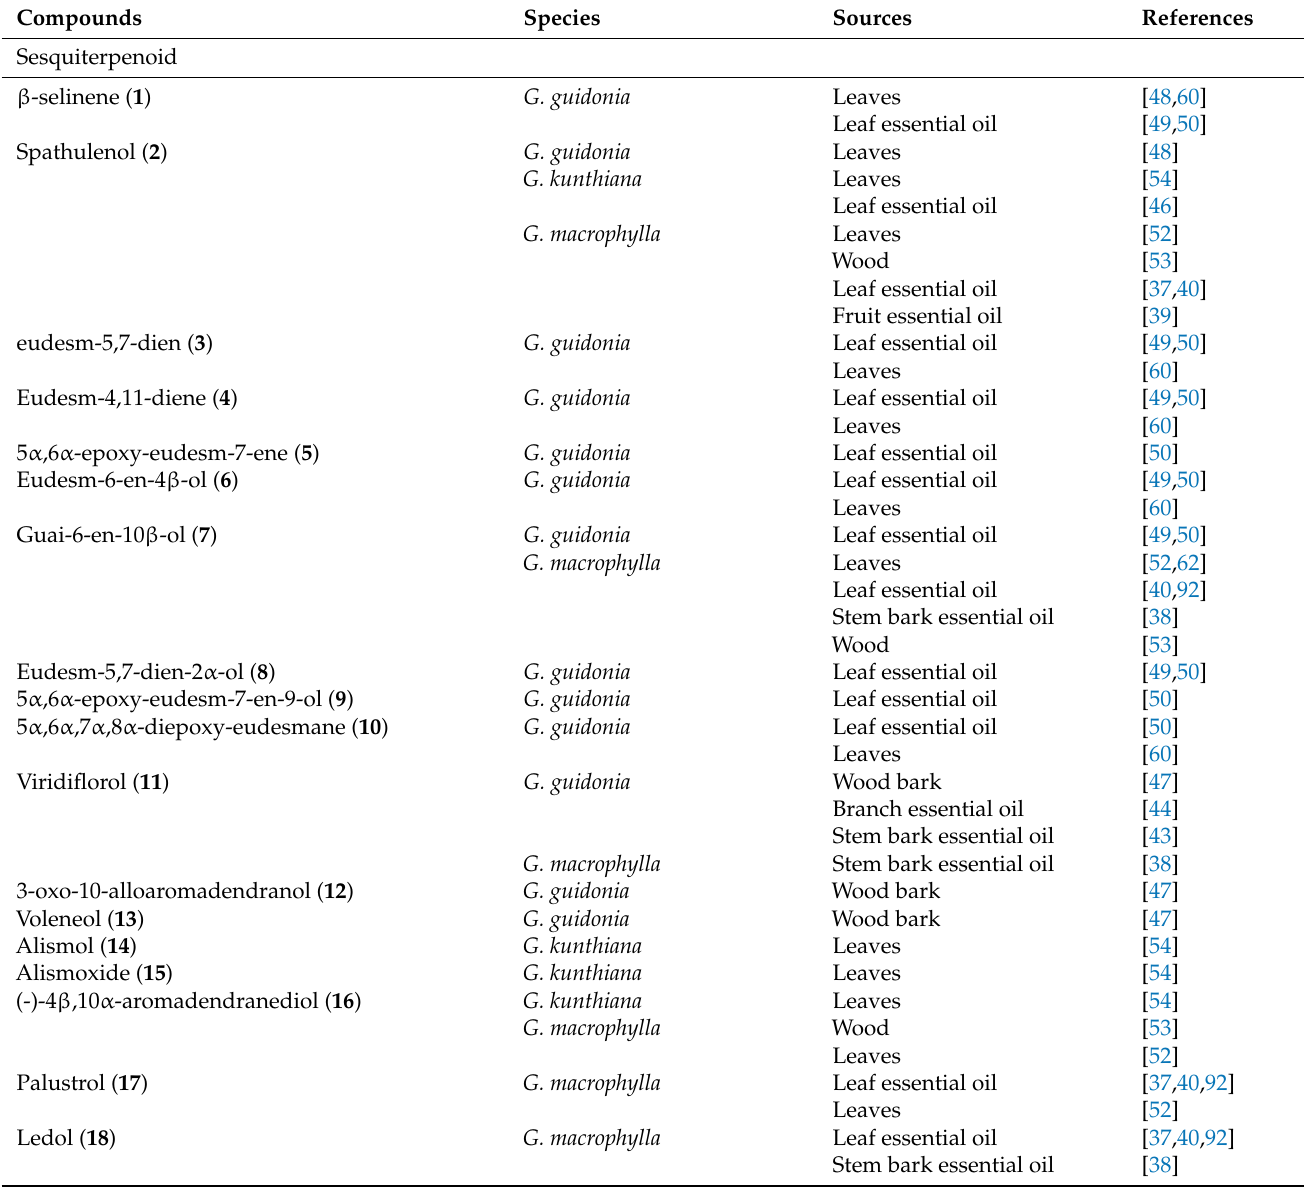
Table 1. Terpenoid and other compounds from Guarea